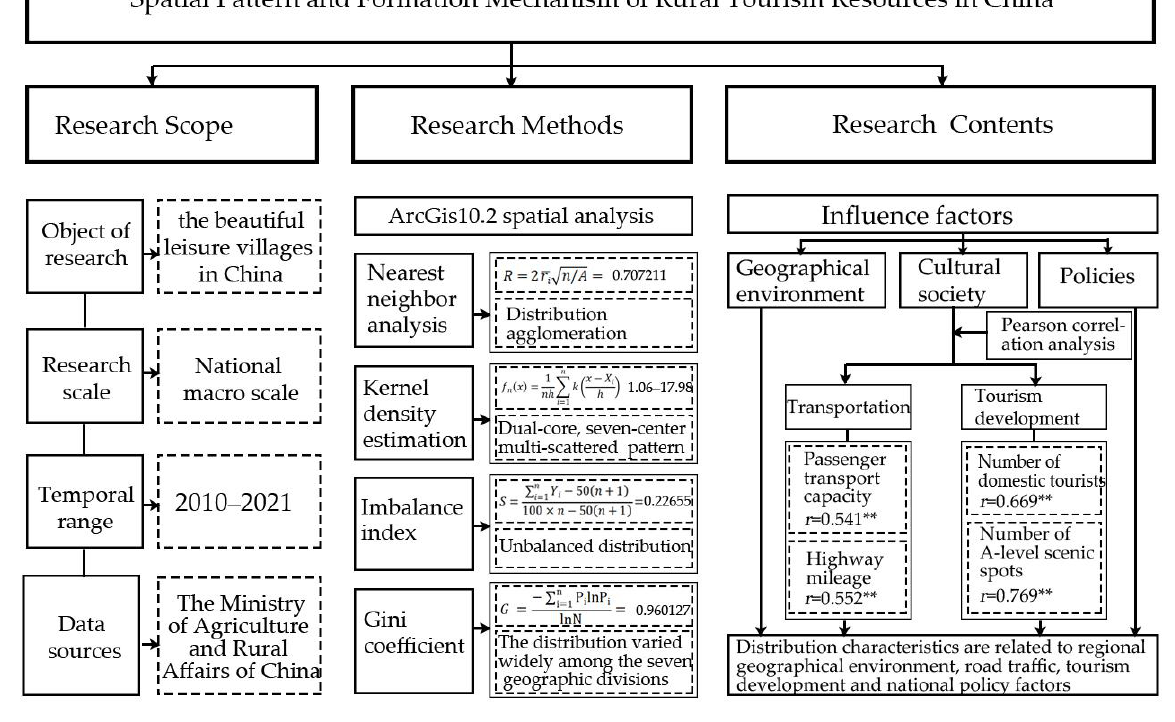
Figure 14. Research results